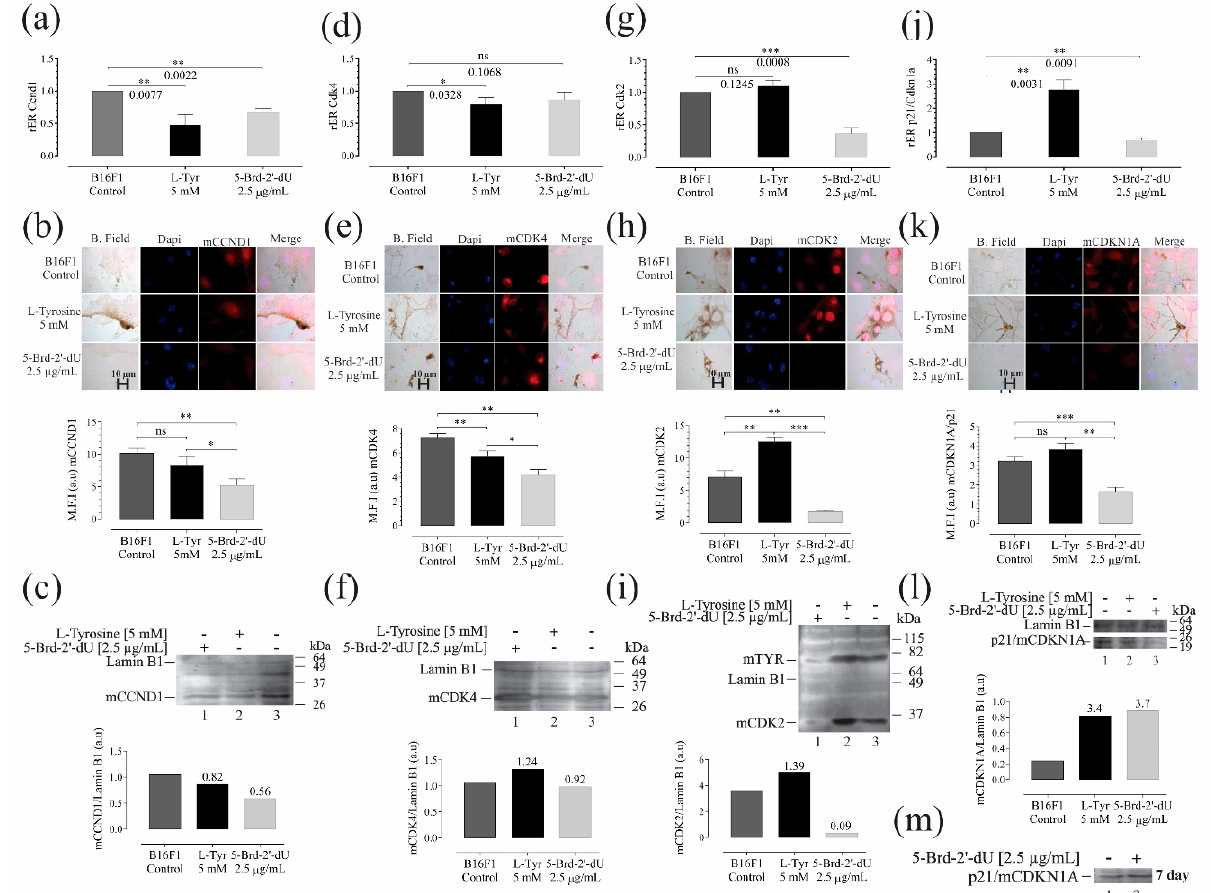
Figure 5. Variations in the expression of genes and their protein products, associated with controlling the cell cycle and senescence in B16F1 cells, induced differential pigmentation and decreased proliferation. Relative expression radius (rER) by RT-qPCR, ( n = 4), representative photographs of the location and distribution by immunofluorescence (red) in nuclear counterstain with DAPI (blue), quantification of expression by mean fluorescence intensity (MFI), and western blot for CCnd1 ( a – c ), Cdk4 ( d – f ), Cdk2 ( g – i ) and p21 ( j – m ). The level of significance (*) using two-tailed multiple t -tests. The differences were considered statistically significant for a p -value < 0.05, ns: not significant. Significant (*) with p < 0.05, very significant (**) with p < 0.01, highly significant (***) with p <